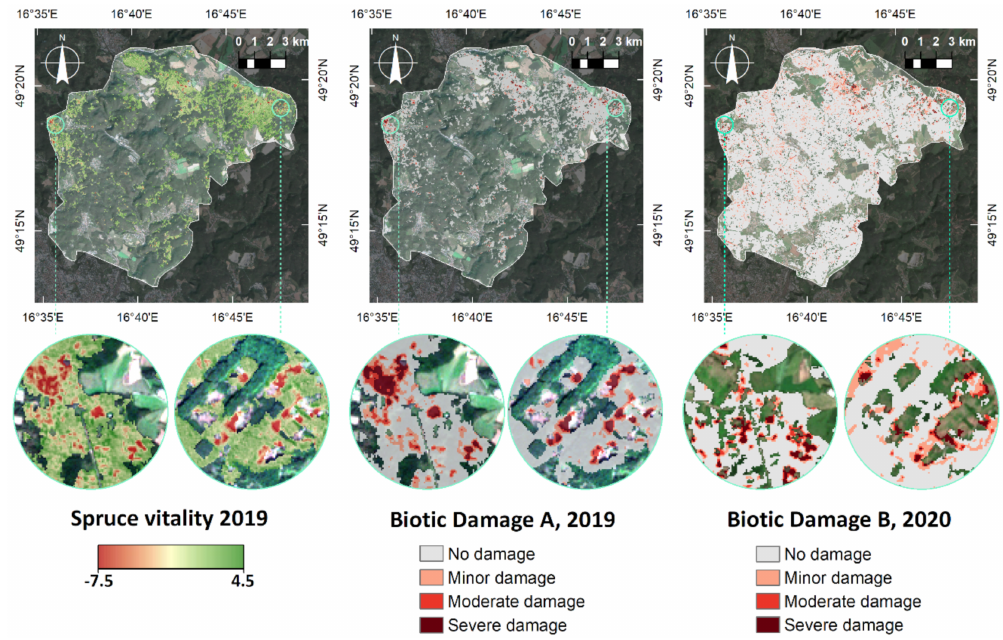
Figure 8. Maps of spruce vitality in 2019 ( left ), BDA19 ( middle ), and BDB20 ( right ). Images: Sentinel-2 acquired on 2019-08-29 (Spruce vitality 2019 and BDA19) and 2020-07-01 (BDB0) in true color composition (blue / green / red). BDA, biotic damage A; BDB, biotic damage